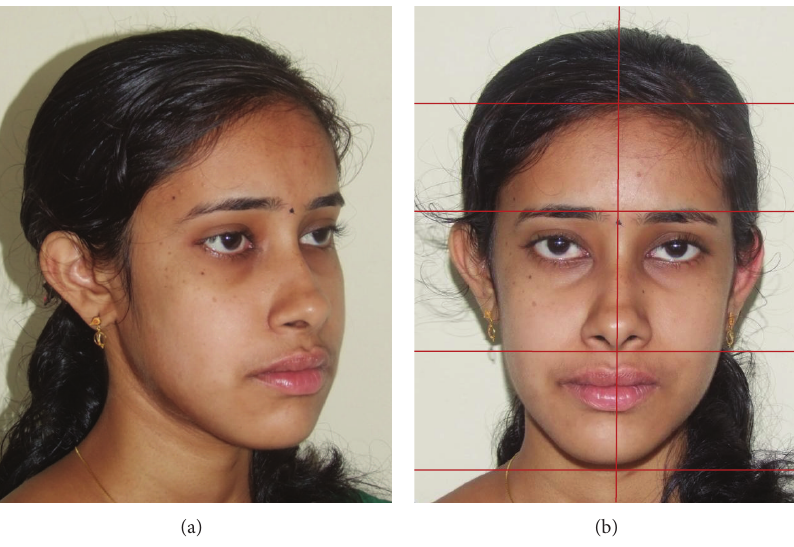
Figure 17: Posttreatment face: (a) oblique, and (b) vertical proportions and